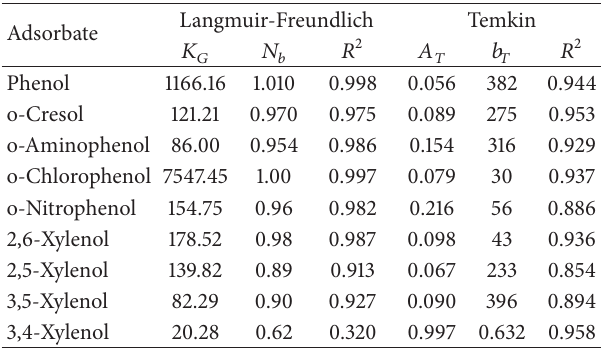
Table 3: Isotherm constants and regression data for Langmuir- Freundlich and Temkin isotherms for adsorption of substituted phenols on asphaltene from aqueous